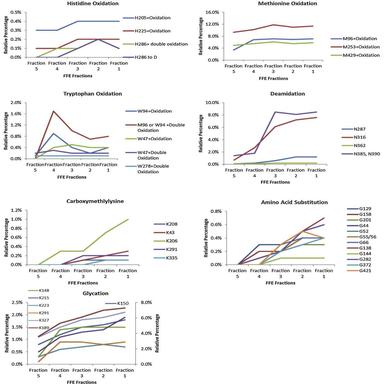
Relative abundance of modification products identified in FFE fractions.